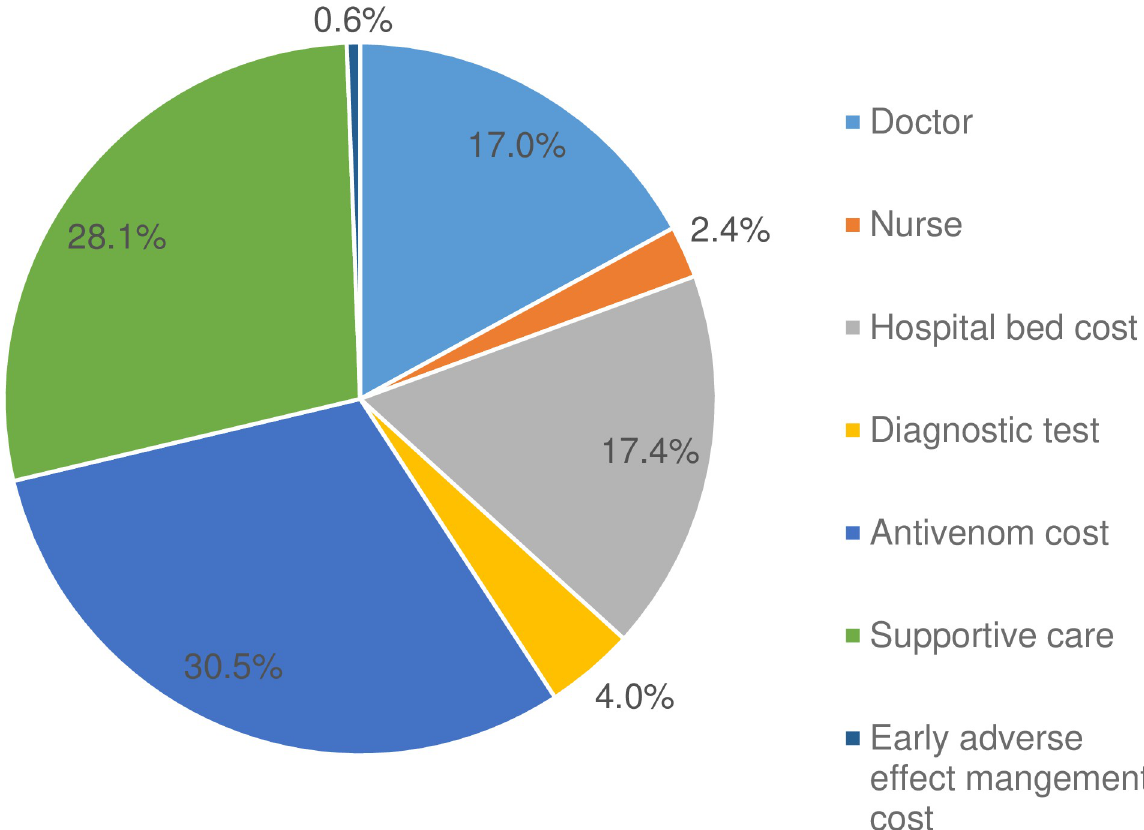
Fig 5. The percentage share of total hospitalisation cost by